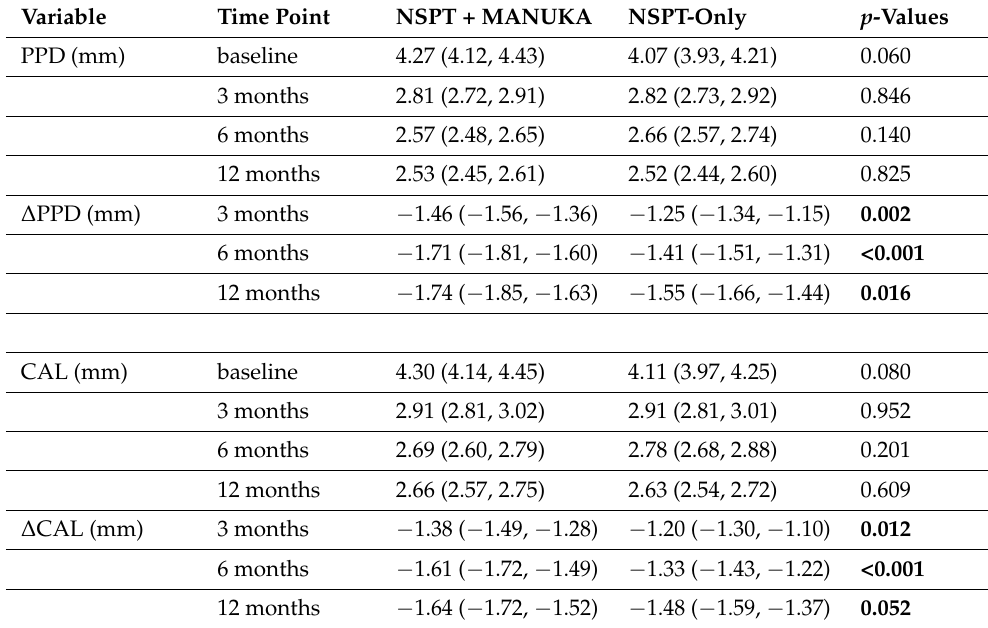
Table 1. Measured values of periodontal pocket depth, clinical attachment level, and changes of these parameters from the baseline values. All data are represented as mean values with 95% confidence interval limits in parentheses.